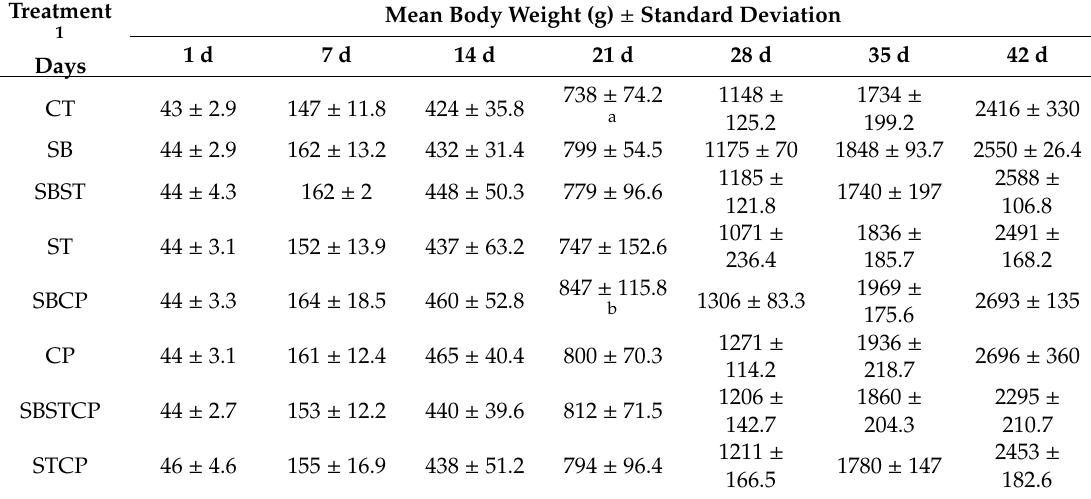
Table 3. E ff ect of dietary supplementation with a Synbiotic mix on the body weight of birds challenged with Salmonella Typhimurium and Clostridium perfringens